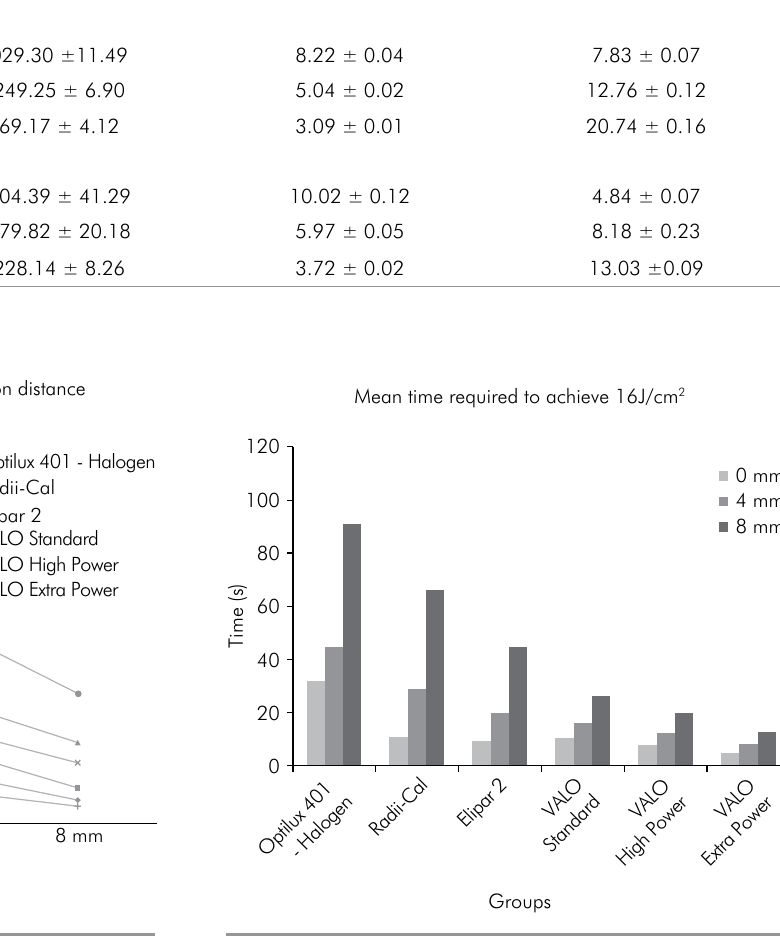
Figure 1. Mean loss of irradiance versus emission distance from the tip to the